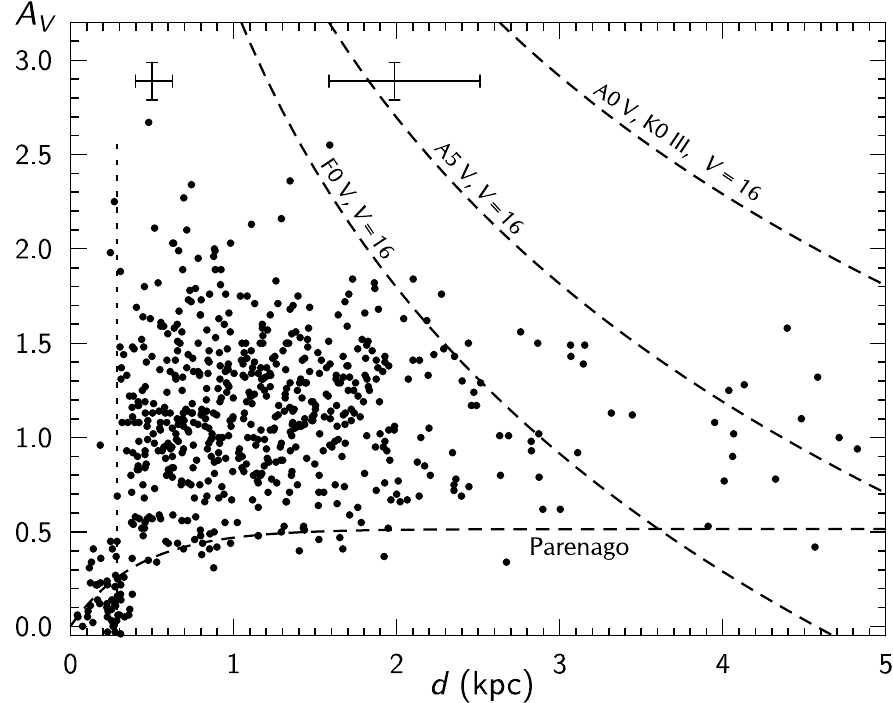
Fig. 2. The dependence of the extinction on distance for the whole area. The three dotted curves show the limiting magnitude effect for A0 V, A5 V and F0 V stars. The A0 V curve is also valid for K0 III giants. The lower segmented curve is the dependence of the extinction on distance for the Galactic latitude +15.5 ◦ calculated by the Parenago formula (see the text). The error bars correspond to standard deviations of the distance and the extinction at 0.5 kpc and 2 kpc distances. The dotted vertical line marks the estimated distance of the dust clouds at 286